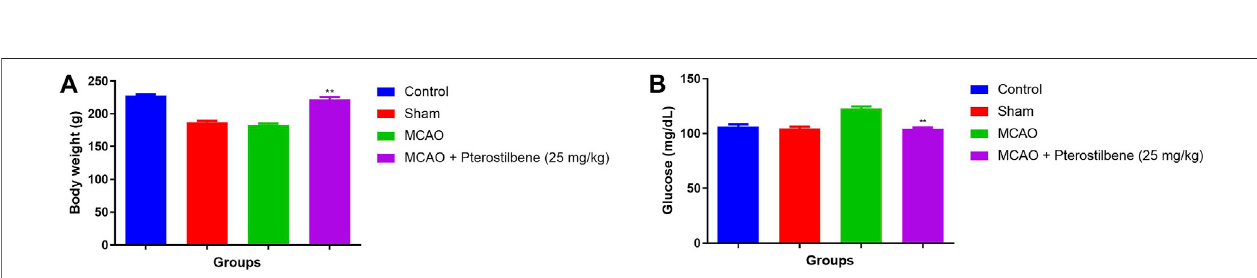
FIGURE 1 | showed the neurological parameter and score of among experimental groups. (A) neurological score, (B) infarct volume, (C) brain edema, (D) evans blueleakageand (E) brainwatercontent.Valuesareexpressedasmean ± SEM.The t -testwasusedforthesigni fi cantdifferencebetweengroups:* p < 0.05,** p < 0.01, *** p < 0.005. NS, non-signi fi cant.